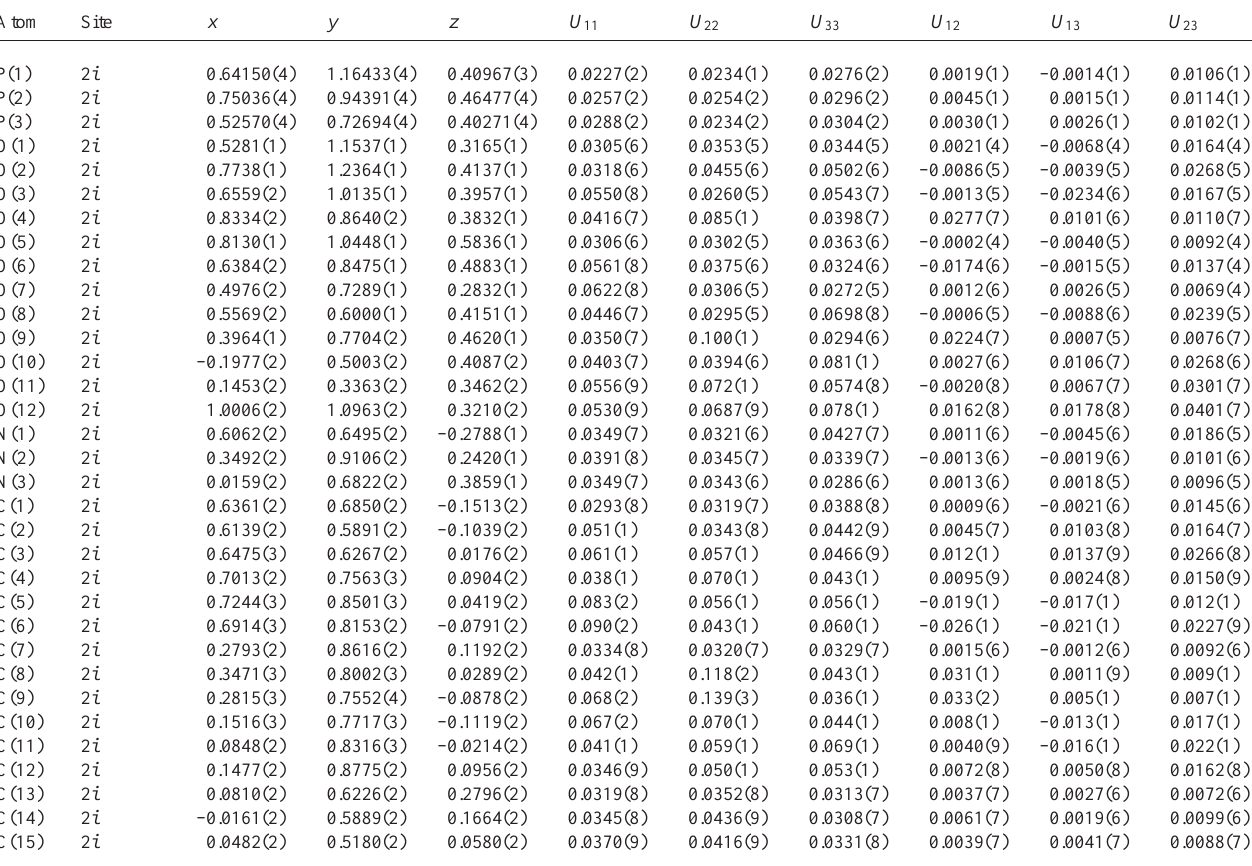
Table 3. Atomic coordinates and displacement parameters (in Å 2 )